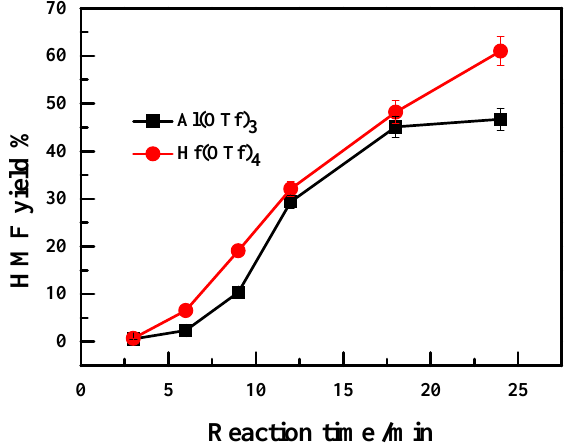
Figure 8. Effect of valence state of Lewis acid salts on the yield of HMF. Reaction conditions: reaction temperature of 160 °C, reaction time of 25 min, 0.1 g glucose in 1.5 g 25 mM Lewis acids aqueous solution, 3 g sec-butyl phenol.